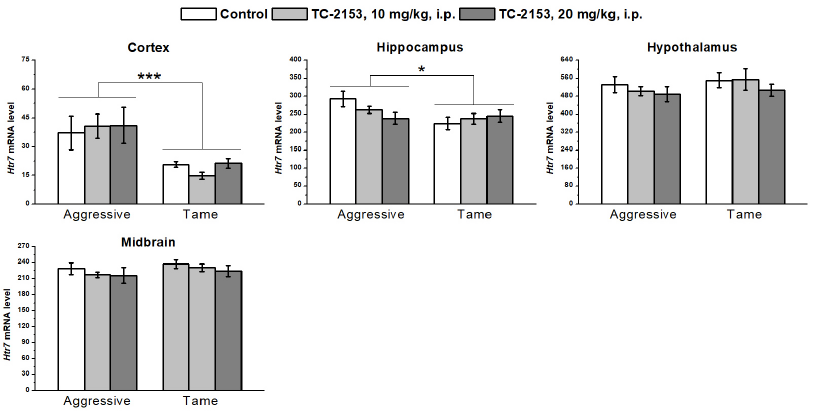
Figure 6. Effects of acute administration of vehicle (control) or TC ‐ 2153 at a dose of 10 or 20 mg/kg on 5 ‐ HT 7 receptor ( Htr7 ) mRNA levels in the cortex, hippocampus, hypothalamus, and midbrain of aggressive and tame rats. The expression levels were determined as the number of transcript copies per 100 copies of Polr2a mRNA. * p < 0.05 and *** p < 0.001 for the genotype effect (5–7 animals per group).